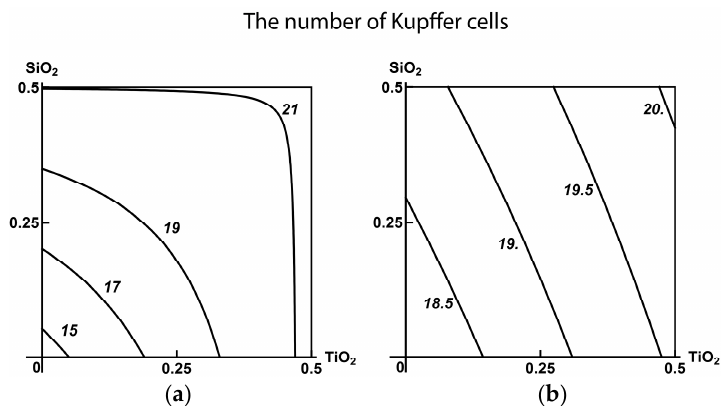
Figure 8. Isobolograms of combined subchronic toxicity of SiO 2 -NP + TiO 2 -NP assessed by an increase in the number of Kupffer cells: ( a ) subadditivity of unidirectional action in the absence of a third MeO-NP; ( b ) additivity in the presence of Al 2 O 3 -NP (an example of three-factor effect falling within class A). The axes represent doses of corresponding MeO-NPs in mg per rat; the numbers at the isoboles denote the magnitude of the effect (expressed in %—see the text).